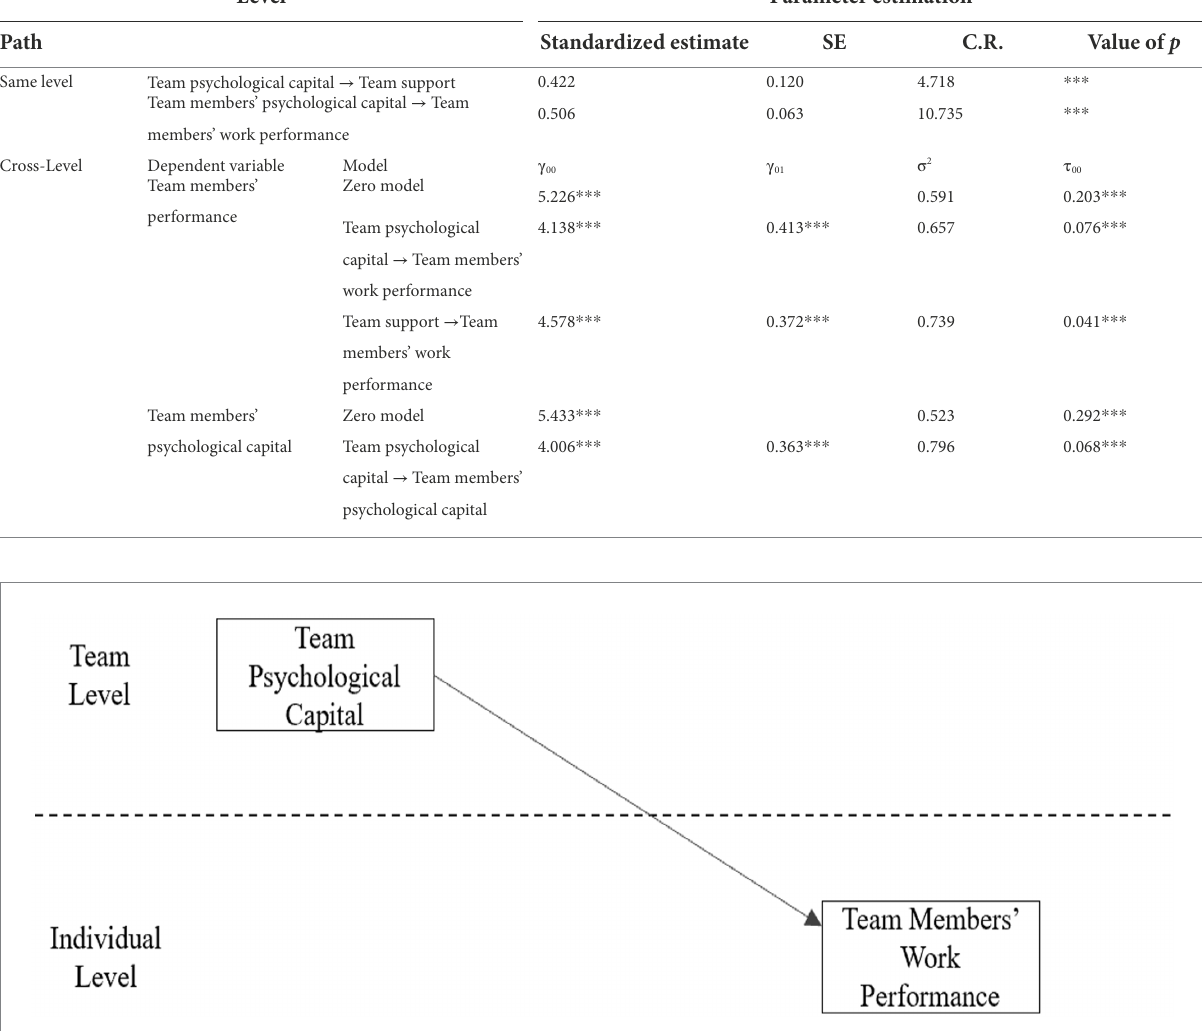
FIGURE 1 The main effect of team psychological capital and team members’ work